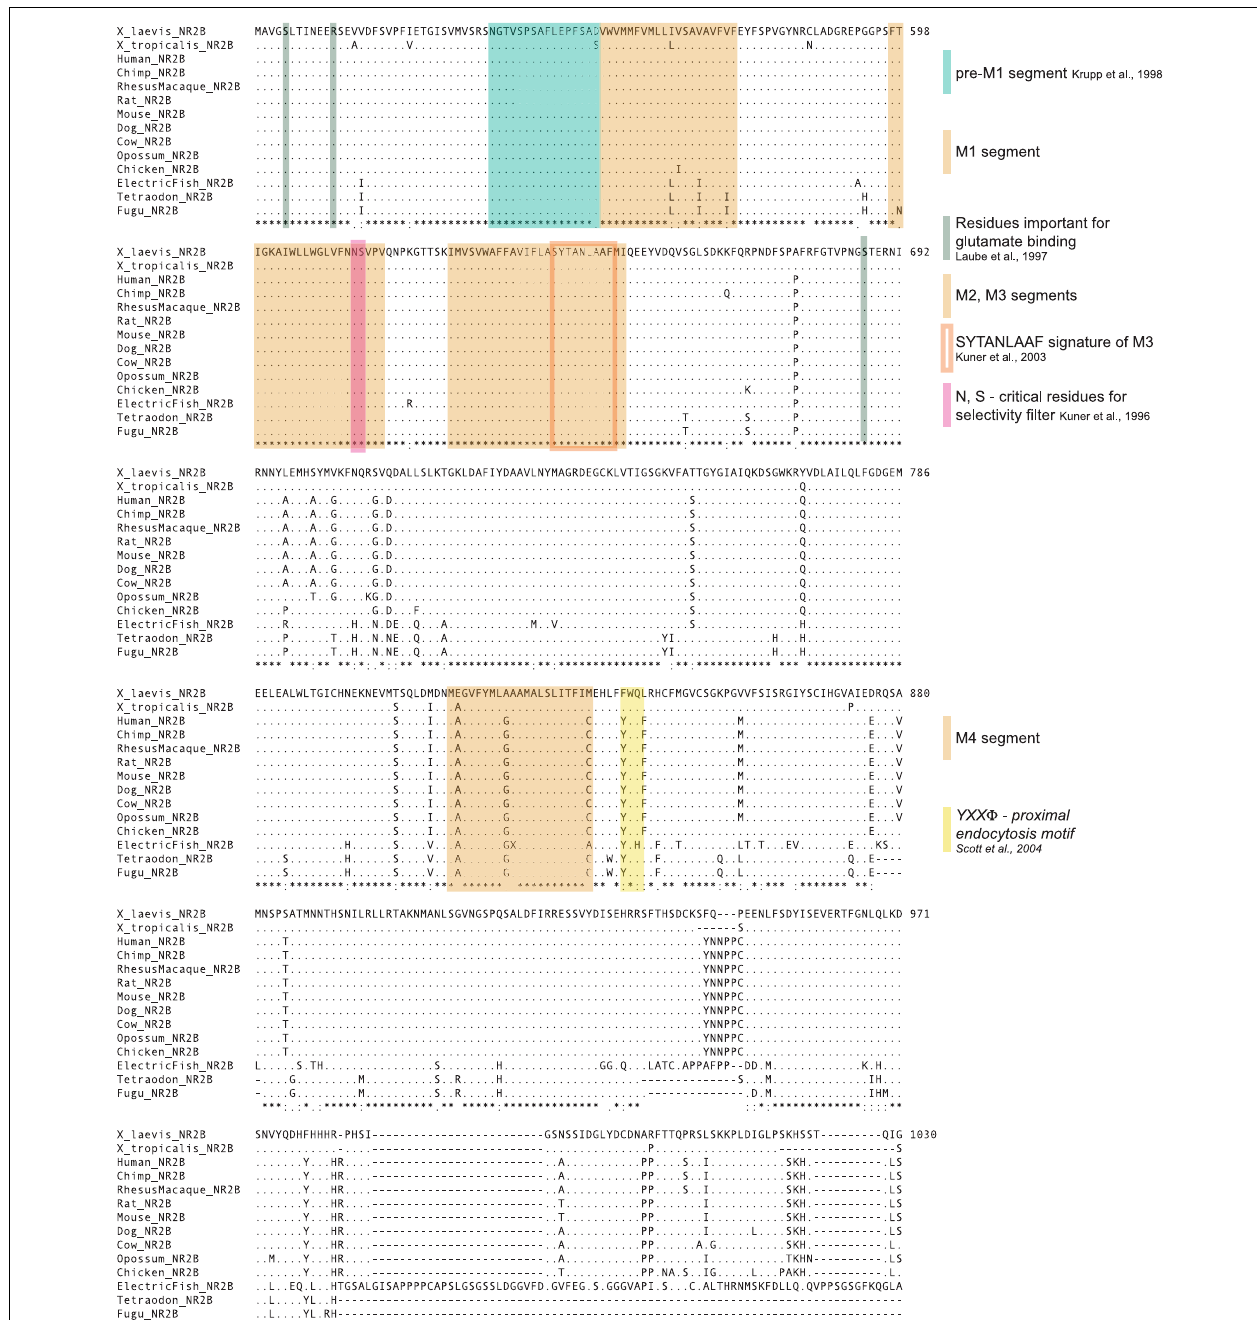
FIGURE 5 | Protein sequence alignment of NR2B from 14 different species. The protein sequences of X. laevis NR2B and 13 other species were aligned with the ClustalW algorithm. When full sequences were not available or could not be assembled by hand, incomplete sequences were used. Amino acids identical to the reference sequence are depicted as (.). Lack of sequence is symbolized by ( − ). A (*) below the alignment signifi es amino acid identity, while